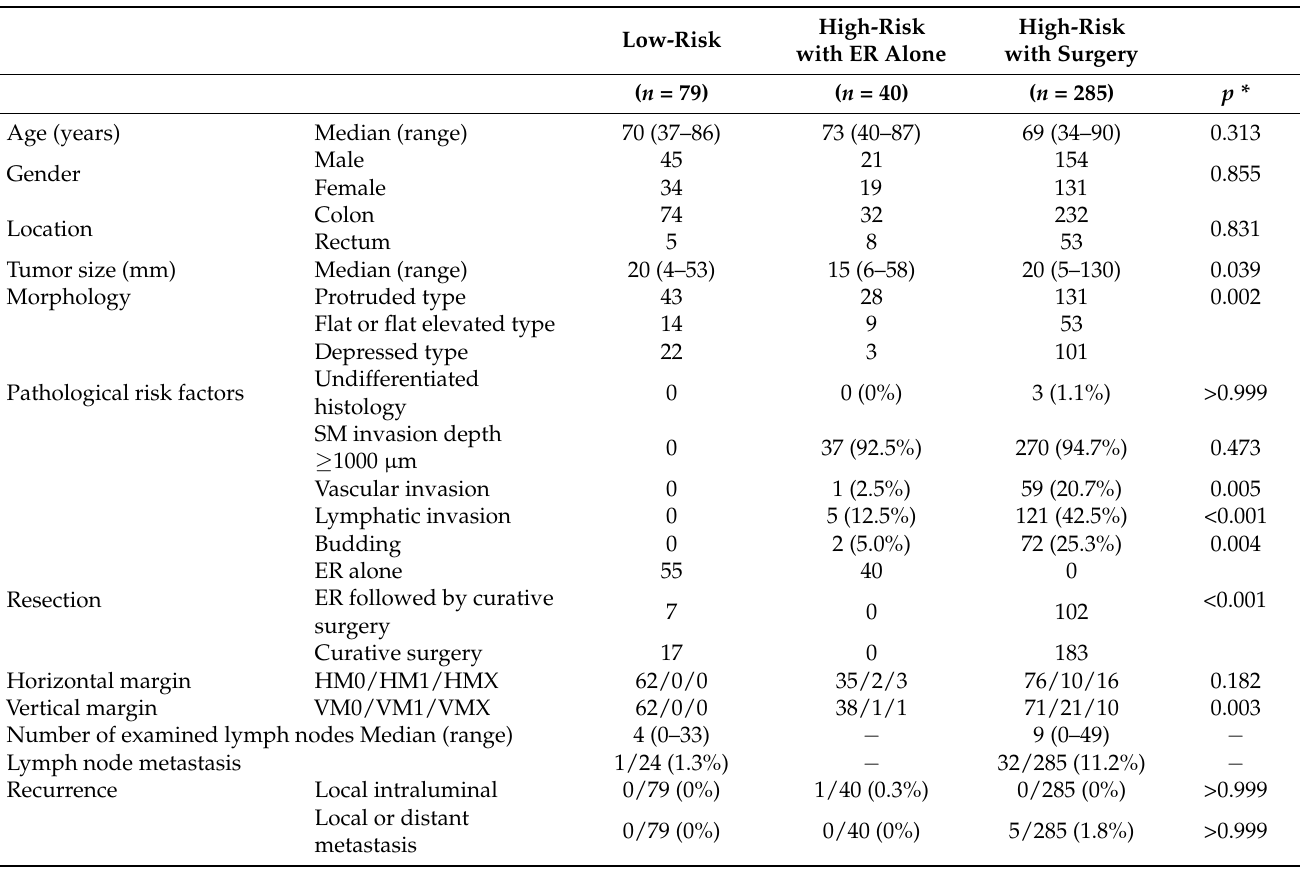
Table 1. Patients’